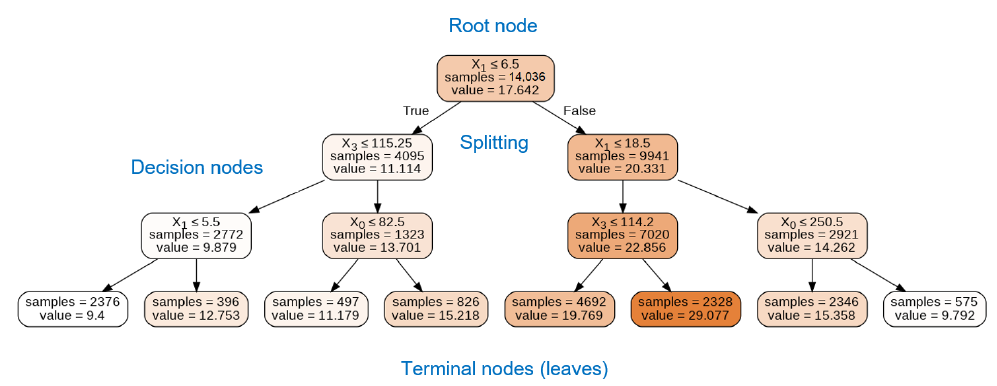
Figure 1. A small decision tree (maximum depth is 3) for VTEC nowcasting (10°10°) based on input data of temporal information, solar and magnetic activity, and output of VTEC. Inputs (cid:101) x p are denoted by the indices 0, 1 and 3, which correspond to DOY, HOD and F10.7 index, respectively. Since the tree is small, it takes into account only inputs that have the highest impact on VTEC. Growing a larger tree will result in more nodes that can consider other inputs as